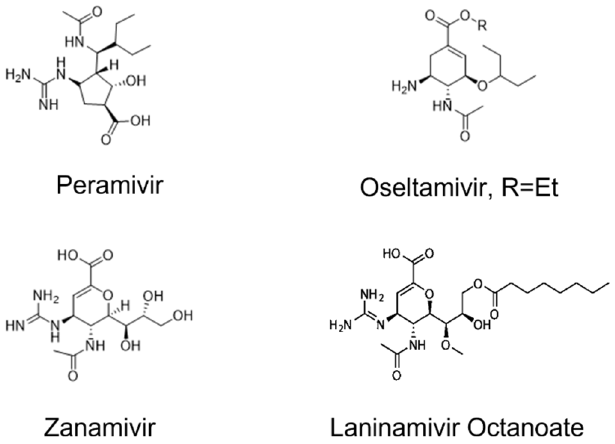
Figure 1. Structure of neuraminidase inhibitors. Neuraminidase inhibitors function by inactivating the viral NA enzyme [15]. NA is inactivated by blocking its ability to cleave sialic acid residues, thereby preventing the unleashing of the virus and stopping the infection of the host cells [15]. Neuraminidase inhibitors prevent the cleaving of sialic acid by the enzyme, and thereby virus spreading [16]. Several avian influenza subtypes (e.g., H5N1, H7N7, and H9N2) have caused